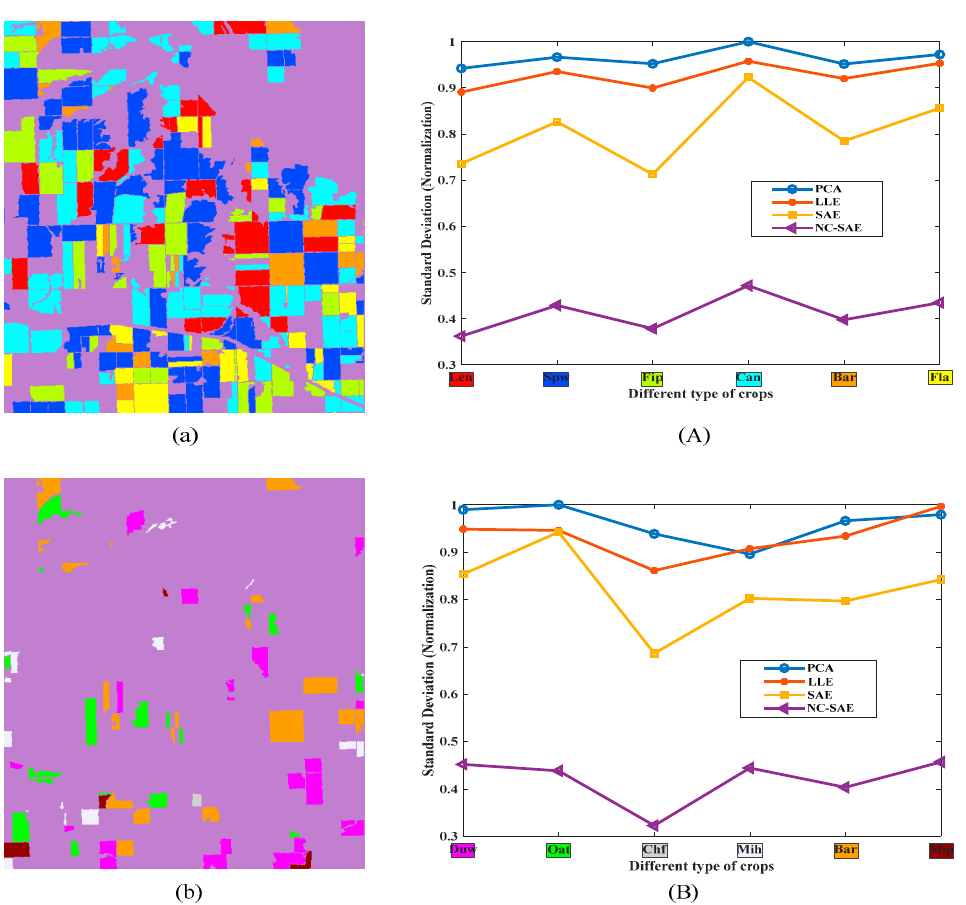
Figure 5. The reconstruction error curves of NC-SAE and SAE.